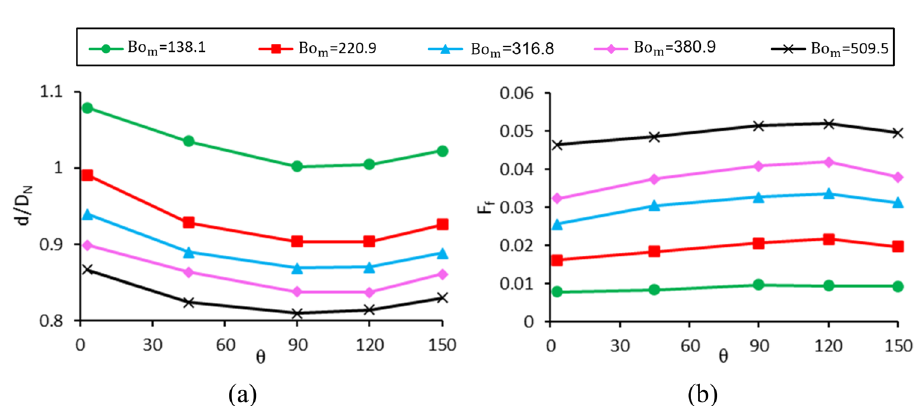
Figure 10. Changes of ( a ) the dimensionless droplet diameter and ( b ) the dimensionless drop formation frequency in terms of contact angle for different magnetic Bond